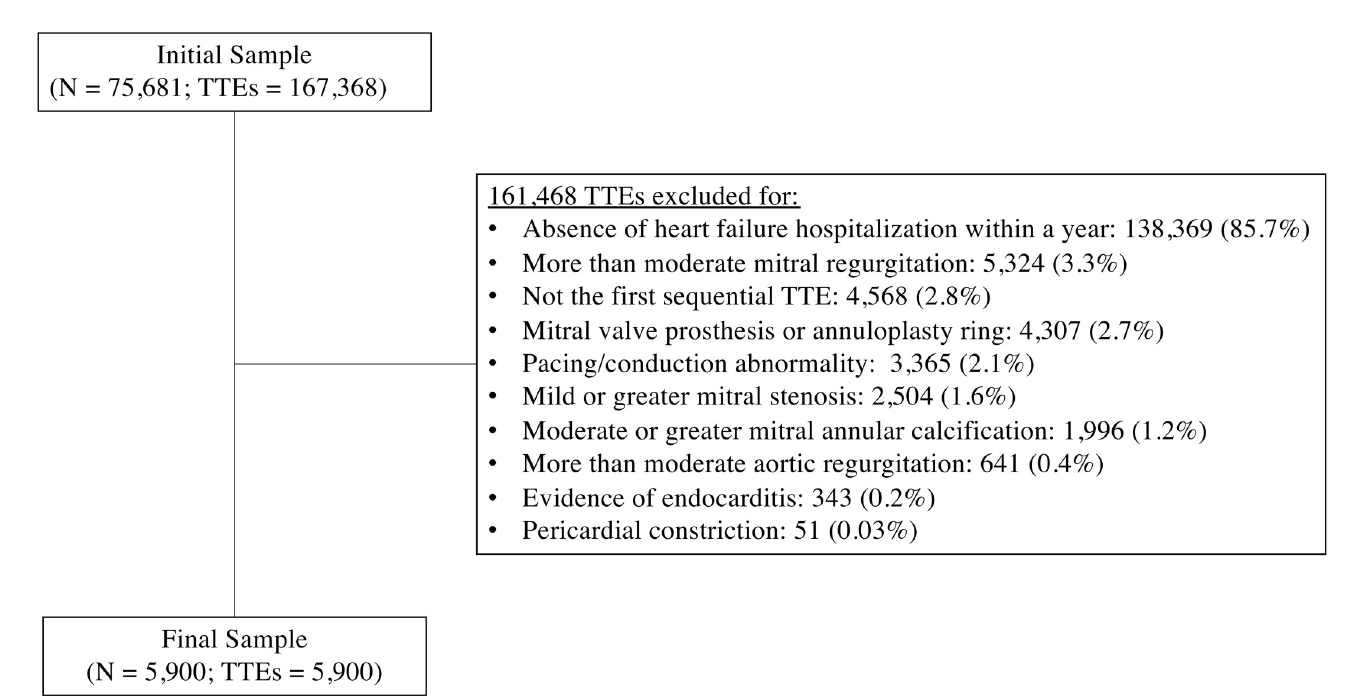
Fig 1. Flow diagram of patients included in study. TTEs = transthoracic echocardiograms.